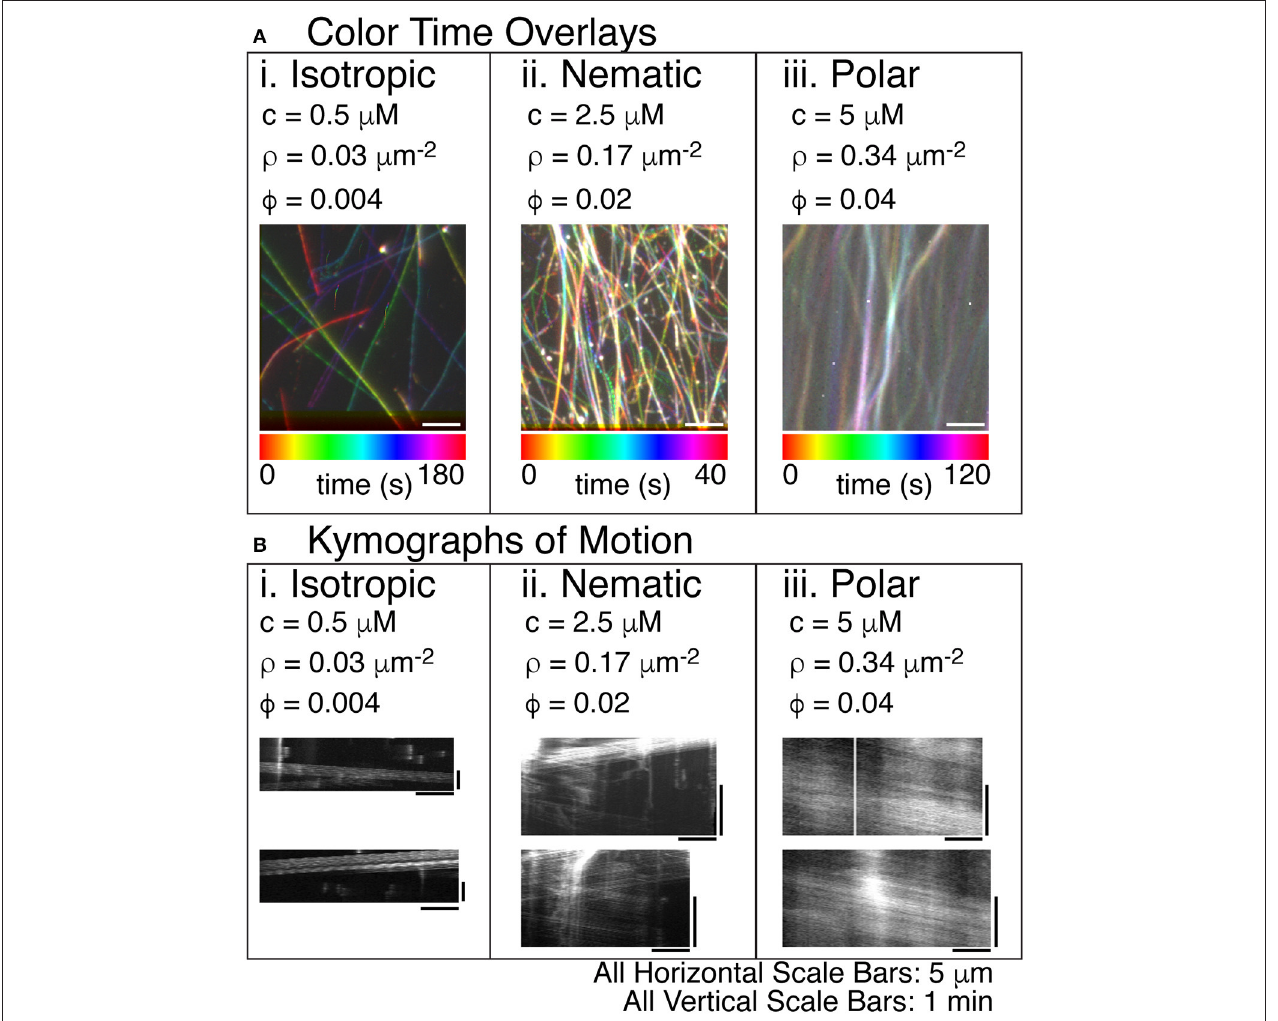
FIGURE 4 | Steady states of microtubule organization as a function of increasing microtubule filament density. (A) Color time overlays where each frame of a timeseries is overlaid as a different color, as indicated by the color scale bar. (i) Lowest concentrations of microtubules display an isotropic phase with filaments pointing in all directions. The concentration (c) is 0.5 µ M tubulin dimers. The filament density ( ρ ) is 0.03 filaments per µ m 2 . The surface area fraction of filaments ( φ ) is 0.004. The color time scale for this image is from 0 to 180s. (ii) The intermediate concentration of microtubules displays a nematic phase with filaments co-aligning locally and moving in antiparallel directions within the high density regions. The c is 2.5 µ M tubulin dimers. The ρ is 0.17 filaments per µ m 2 . The φ is 0.02. The color time scale for this image is from 0 to 40s. (iii) The highest concentration of microtubules displays a polar phase with filaments co-aligning globally and moving in the same directions within the high density regions. The c is 5 µ M tubulin dimers. The ρ is 0.34 filaments per µ m 2 . The φ is 0.04. The color time scale for this image is from 0 to 120s. (B) In order to determine the direction of the filaments within the high-density regions of the images, we created kymographs where the image along the linear region of interest is sequentially layered for each time step. The time dimension is portrayed on the y-axis. The space dimension along the filament is portrayed along the x-direction. (i) For the lowest density of filaments, visible tracks in the color time overlays were used to create kymographs. These tracks were deposited by single filaments, as evidenced by the single trail of intensity in the kymographs. (ii) For intermediate densities of filaments, the dense regions of the color-time overlay were used to create kymographs. The filaments moving in the high density regions were moving in both directions, as evidenced by the diagonal lines in both directions. (iii) For high density filaments, the high density regions of the color-time overlays were used to create the kymograph. All the filaments appear to move in the same direction implying that the high density region has polar-aligned filaments. All scale bars in the x-direction are 5 µ m for all images. All scale bars in the y-direction were 1min in time for all